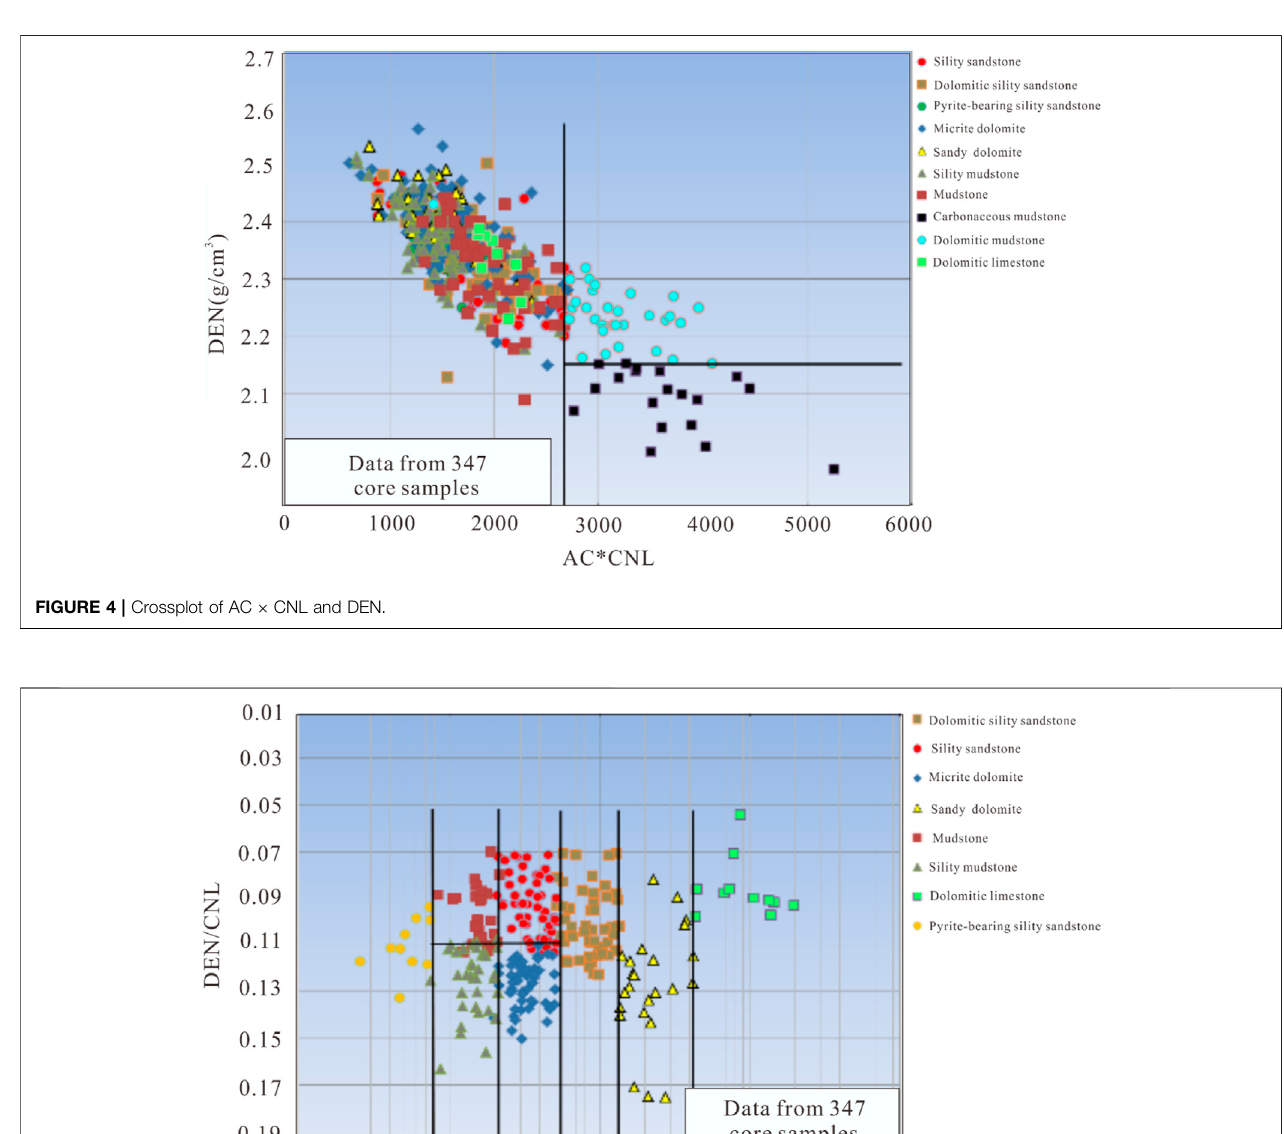
Frontiers in Earth Science |